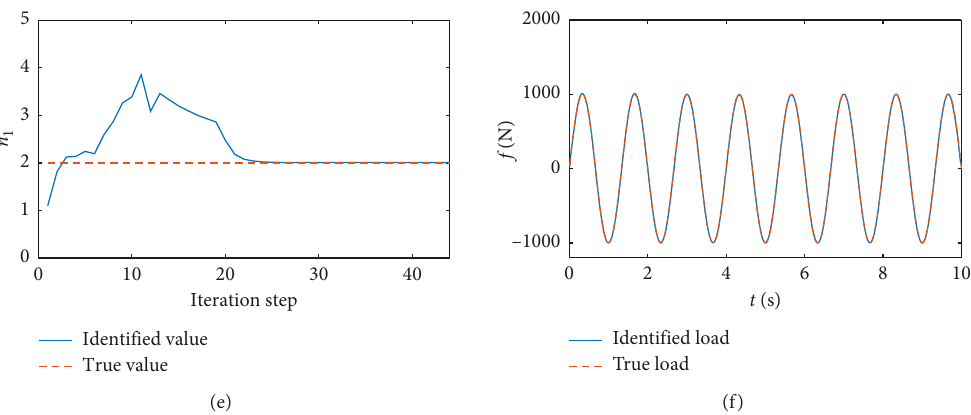
Figure 6: The convergence processes of (a) k Degree of freedom